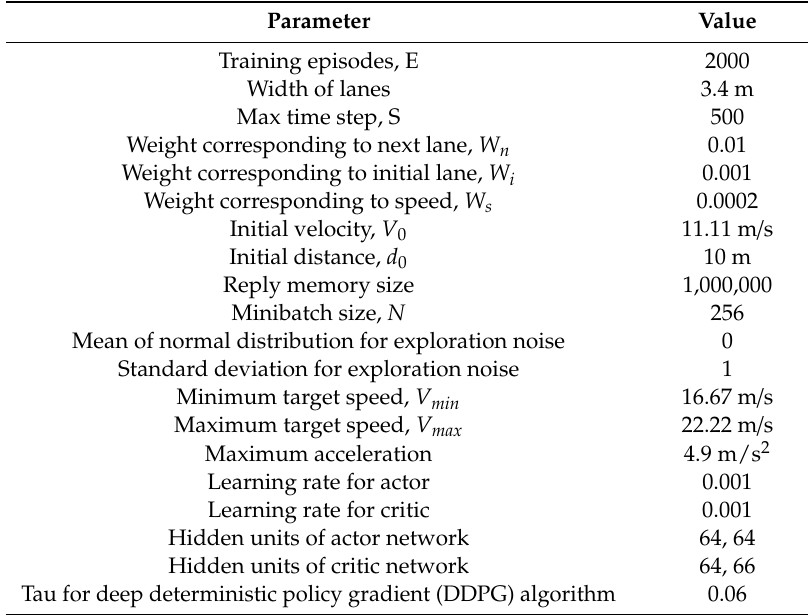
Table 1. Parameters related to lane change system.